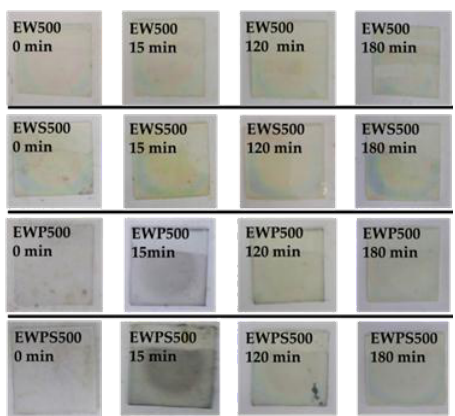
Figure 2. Changes of the appearance of the EW500, EWS500, EWP500, and EWPS500 films (annealed at 500 °C) as the annealing time increased. The color changed from transparent to grey and finally turned transparent again only in the samples EWP and EWPS (PEO-doped), which indicated the carbonization of PEO at high temperature.